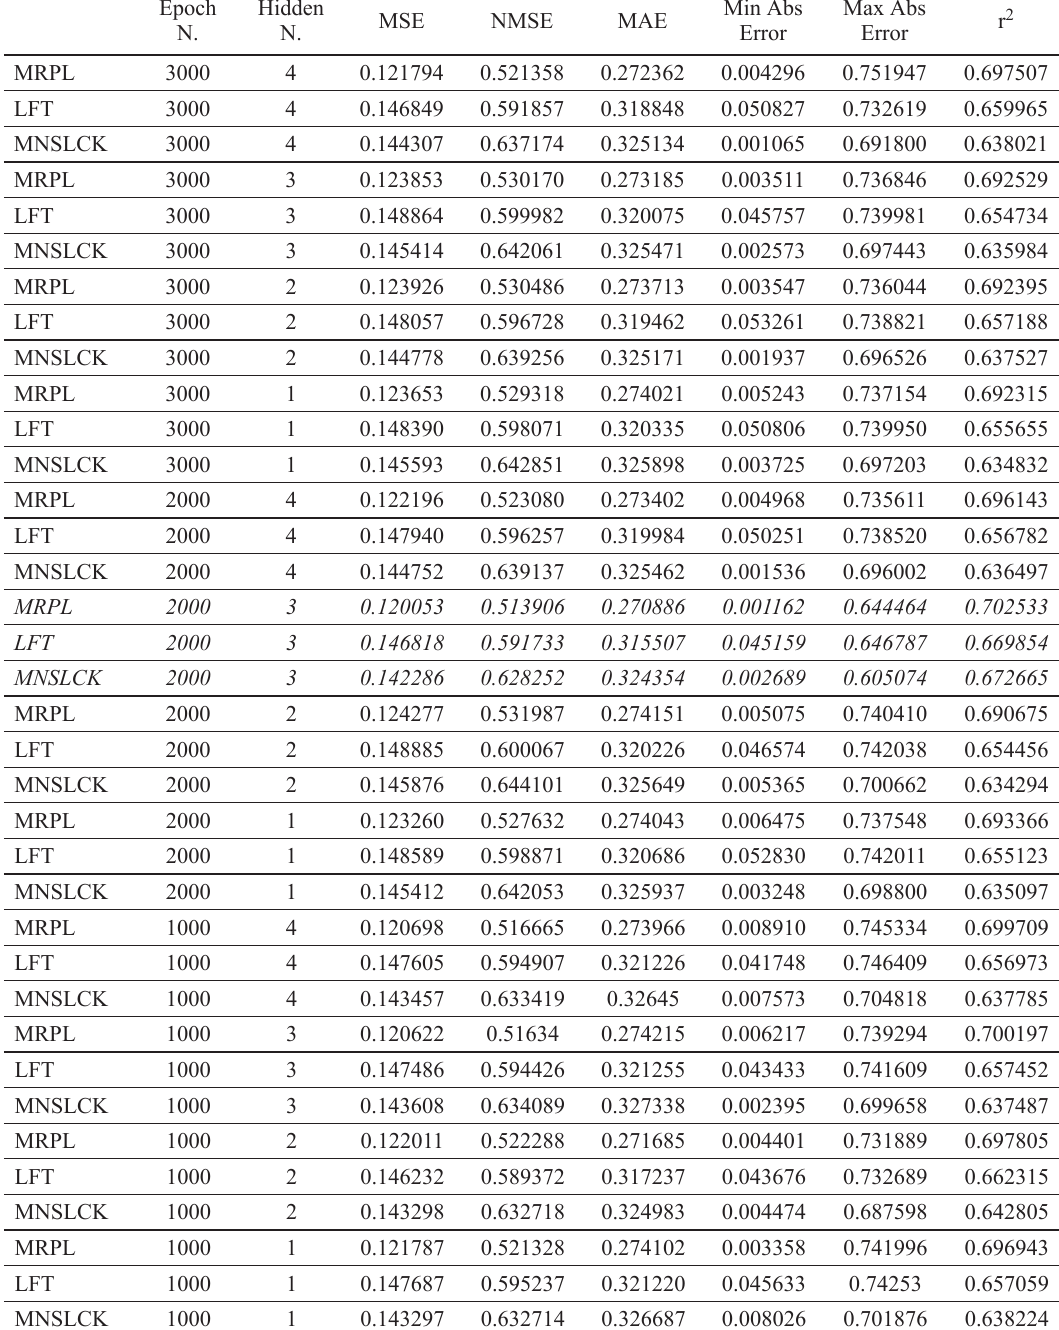
Table 5. Comparison of observed and predicted data from ANN Models Epoch Hidden N.